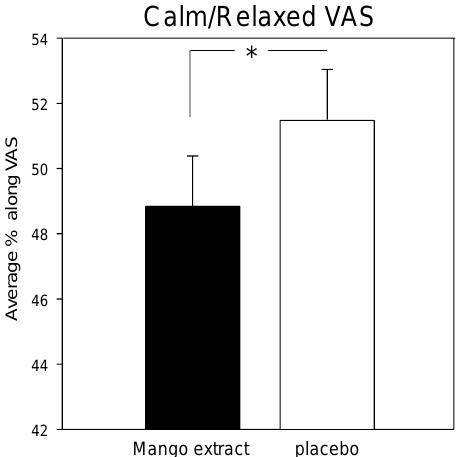
Figure 6. The effects of mango leaf extract on the calm/relaxed stress visual analogue scales (S-VAS) Figure 6. The e ff ects of mango leaf extract on the calm / relaxed stress visual analogue scales (S-VAS) measure. There were no significant differences on the planned comparisons of data from each measure. There were no significant di ff erences on the planned comparisons of data from each assessment. *, p < 0.05 in comparison to placebo. assessment. *, p < 0.05 in comparison to